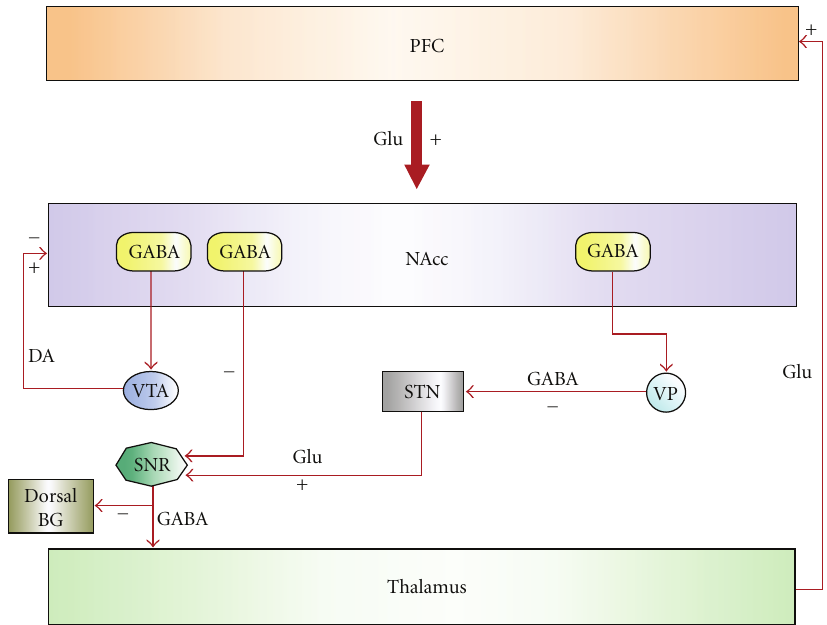
Figure 1: Schematic representation of basal ganglia circuit. In this scheme the nucleus accumbens (NAcc) is an interface through which limbic (glutamatergic) structures influence motor activity, in a way that limbic structures can influence behavior, under control of meso- limbic (dopaminergic structures) system (Ventral Tegmental Area